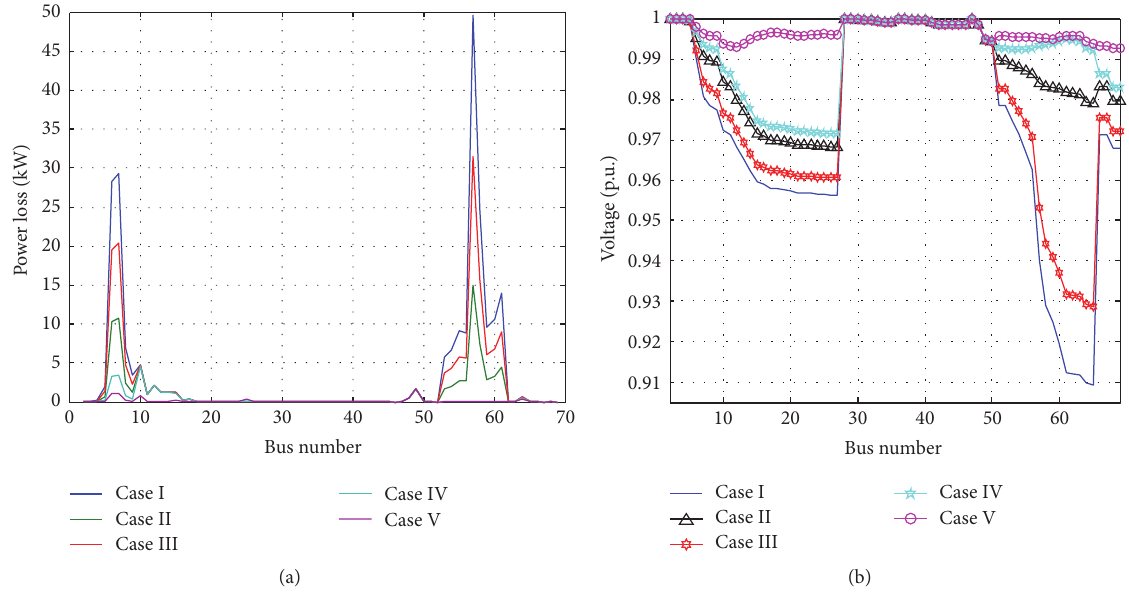
Figure 4: (a) Comparison of line losses for different cases in 69-bus system. (b) Comparison of voltage profile for different cases in 69-bus